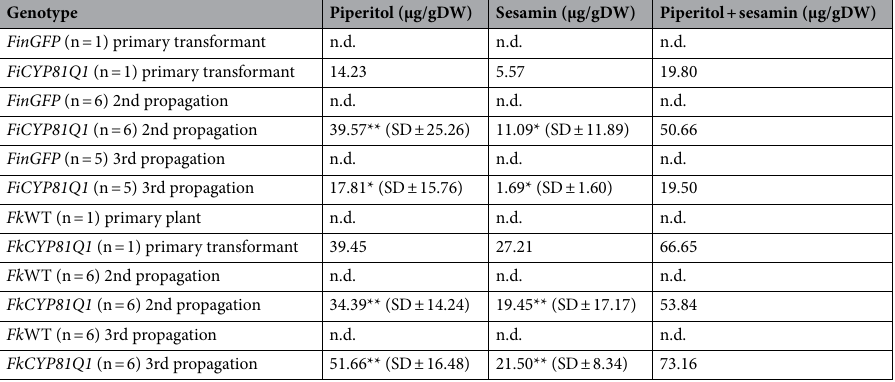
Table 2. The accumulation of (+)-piperitol and (+)-sesamin in Pro35S:CYP81Q1 leaves. n.d. contents below detectable levels. SD standard deviation of six biological replicates. *P < 0.05, **P < 0.01; mean values were significantly different from those of the control by two-tailed Student’s t